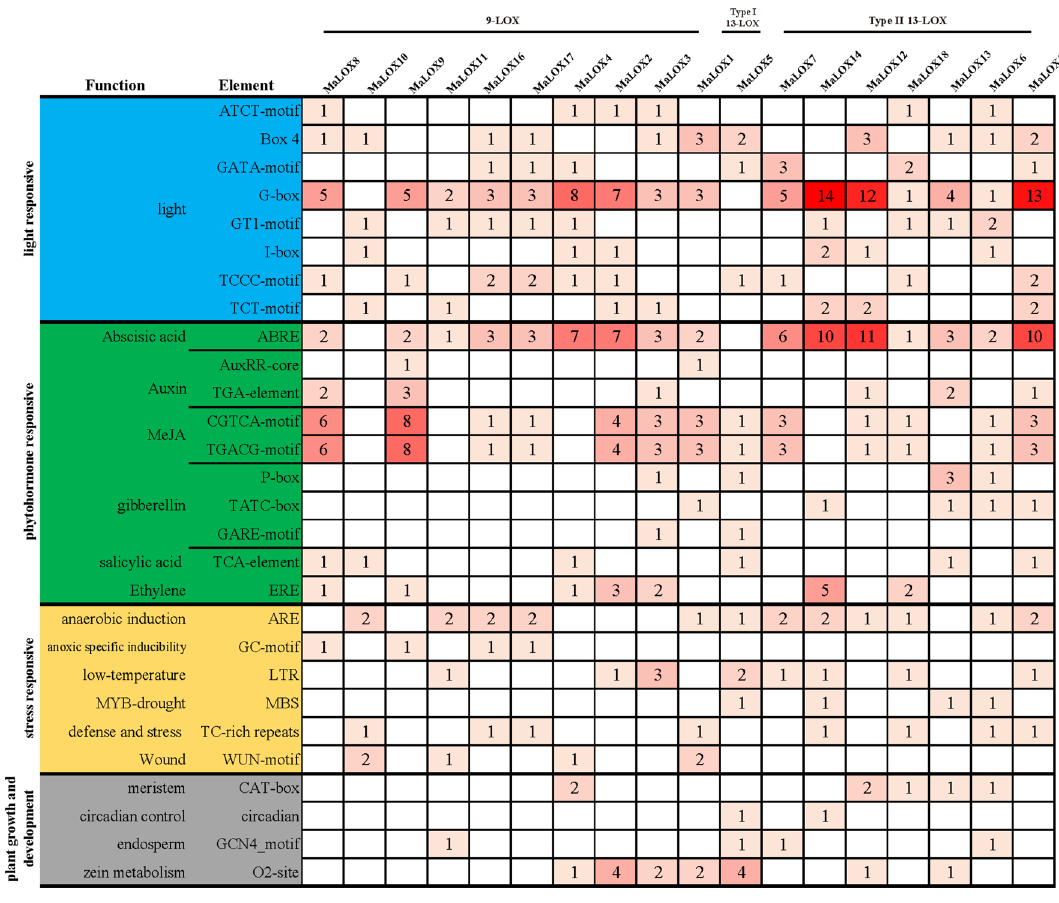
Figure 6. The identified cis -acting elements in MaLOX gene family